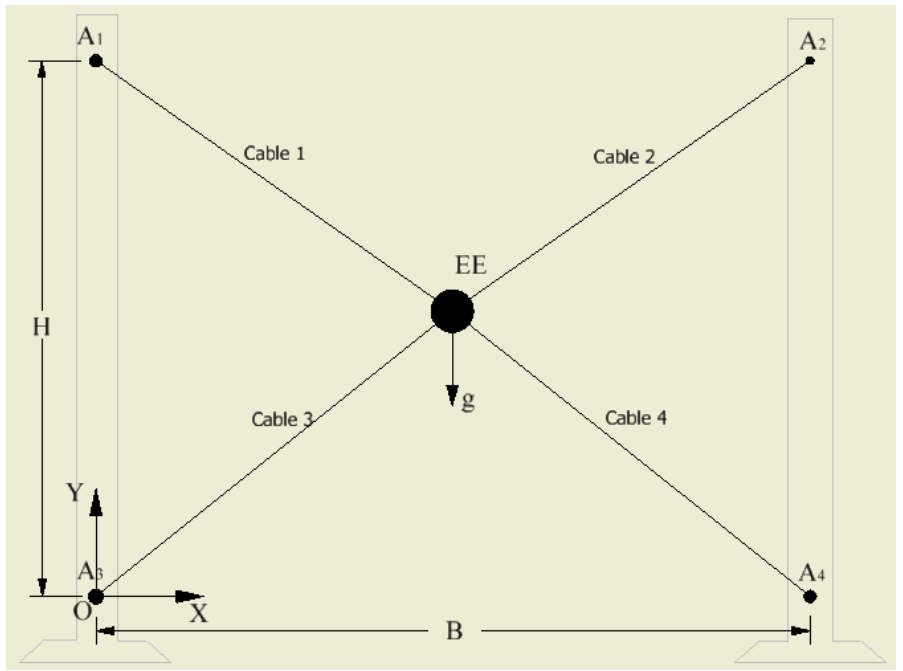
Figure 1. Planar CDPR structure.